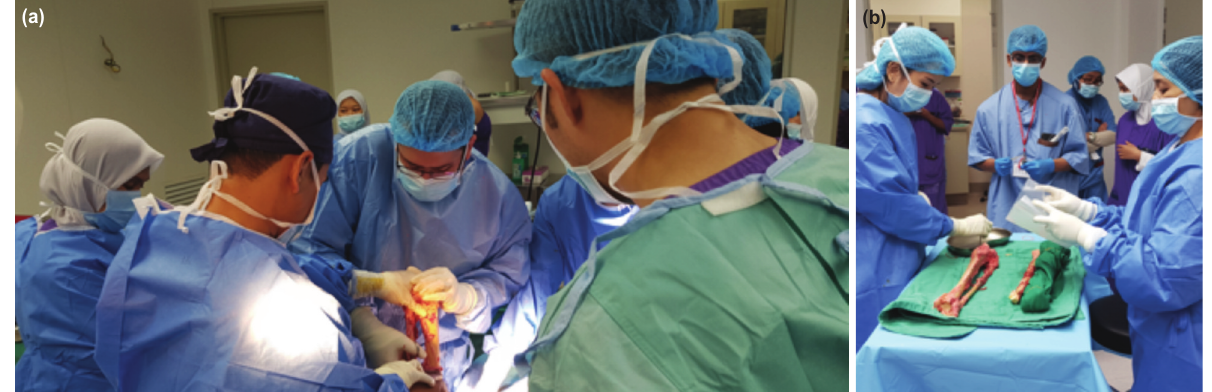
(a) Bone procurement is conducted in an operating theatre. (b) Packing of each procured bone into triple layer of plastic-linen-